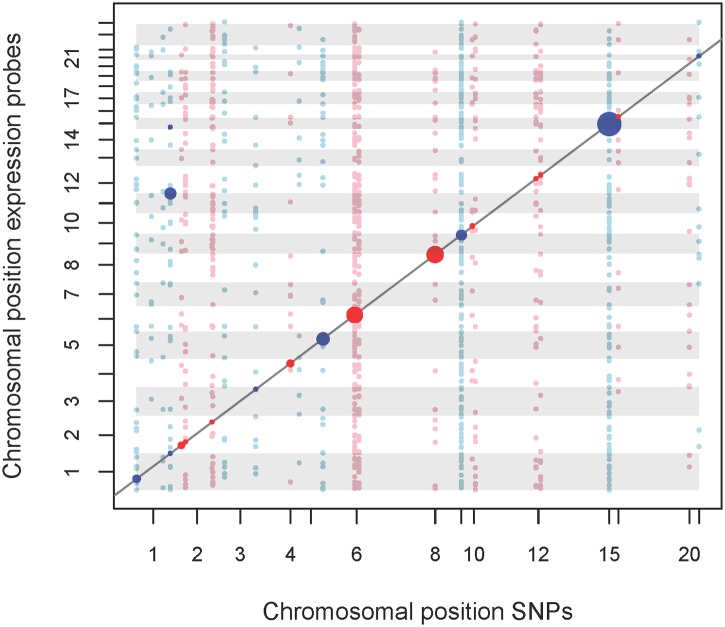
eQTL map of mQTL loci.We analysed the top-SNPs of our mQTL analysis regarding association with gene-expression levels. A total of 54 top-SNPs were correlated with 28,295 probe expressions. Expression probes of auto- and gonosomes were analysed, while SNPs were restricted to autosomes. X-axis represents physical position of SNPs. Y-axis represents the physical position of the start of the regulated transcript. Points located on the diagonal line relate to cis-effects, while other points relate to trans-effects. Associations with FDR = 5% are highlighted. Trans-eQTLs with p-values ≤ 0.001 are also shown. Size of points represents the strength of association. Colors of points and gray shadings indicate distinct chromosomes. An interactive html version of this map allowing exploration of the results is provided as supplemental S7 Fig.